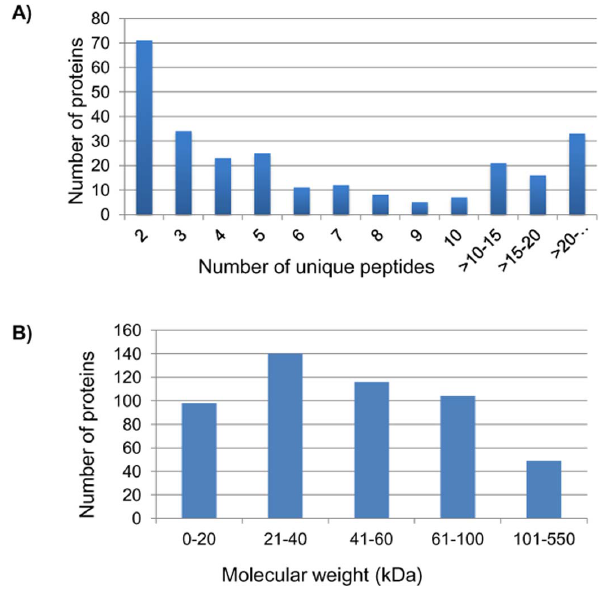
Figure 3. Histograms showing the number of proteins identi- fied with unique peptides and molecular weight distribution of proteins identified in the study. (A) Number of proteins identified based on 2 or more unique peptides. Approximately 70 proteins were identified with 2 peptides. Several proteins were identified with $ 10 peptides. (B) Molecular Weight distribution of the identified proteins. Maximum number of proteins identified had molecular weights in the range 21–40 kDa.